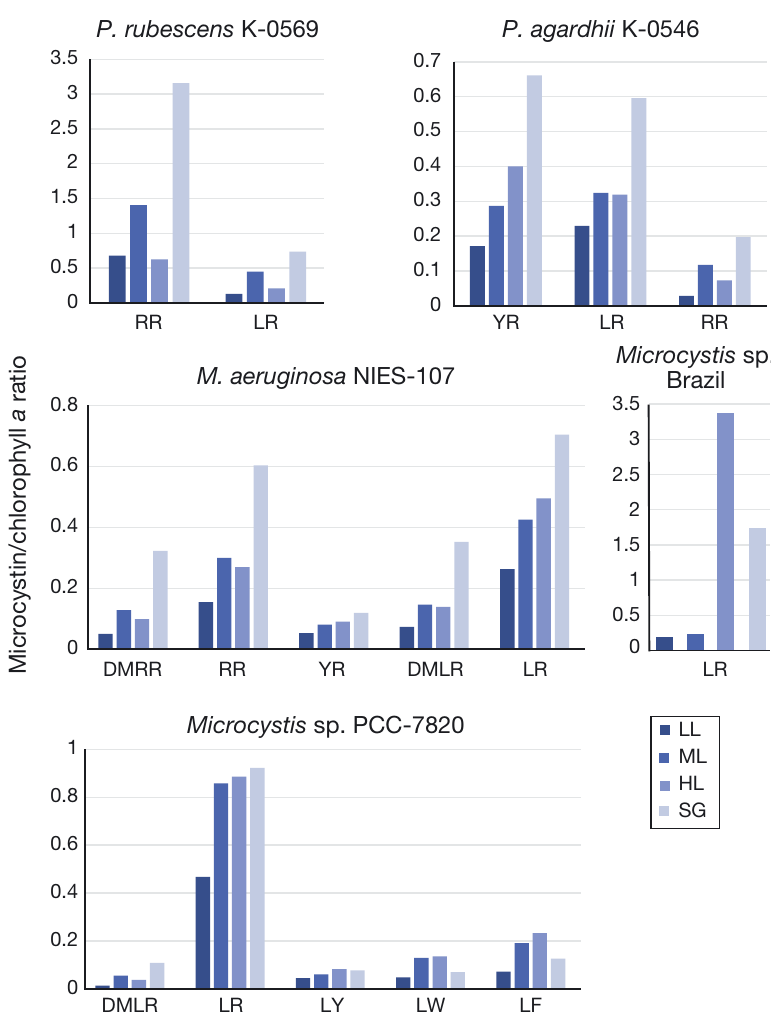
Fig. 2. Content of the different microcystins (LR, RR, YR, DMRR, DMLR, LY, LW, and LF; see ‘Toxin content in cultures’ for details) identified in the cul- tured strains of cyanobacteria ( P. : Planktothrix ; M. : Microcystis ) in relation to chlorophyll a (growth conditions: LL: low light; ML: medium light; HL: high light, SG: stationary